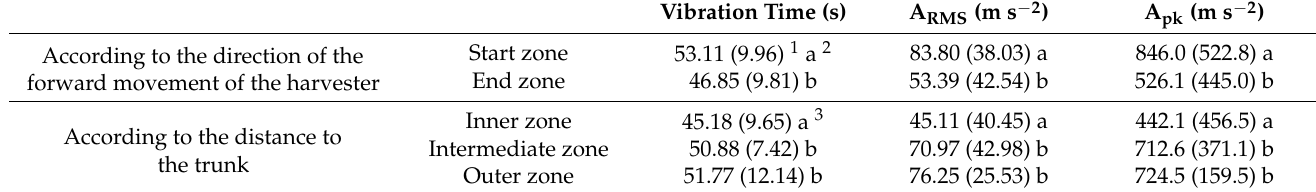
Table 4. Vibration parameter values according to the direction of the forward movement of the harvester and the distance to the